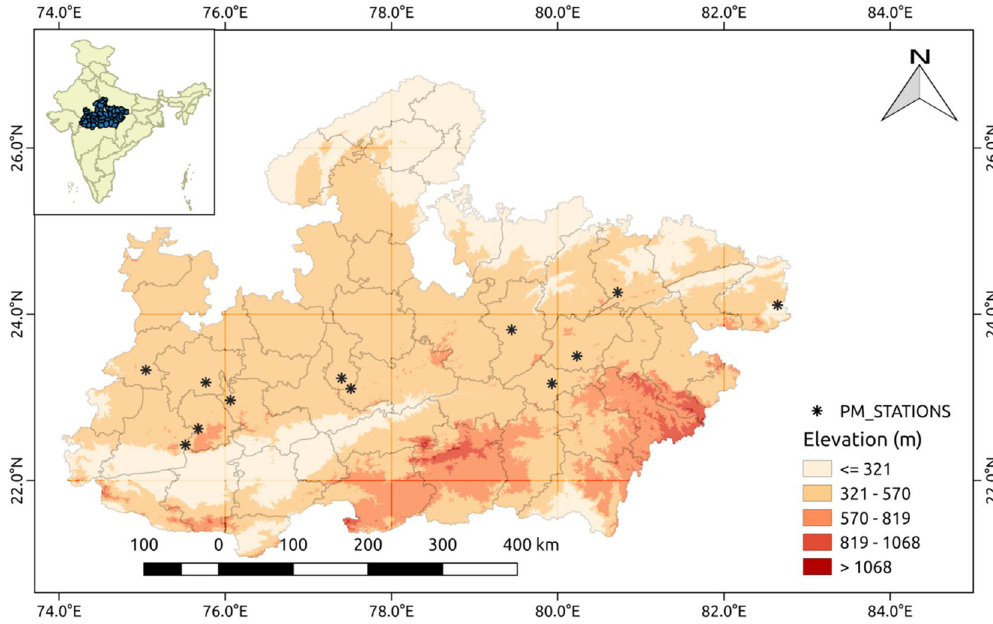
Figure 1. Elevation map (amsl) of the study area and location of PM 2.5 monitors in MP state. This map is generated using QGIS 2.18.1